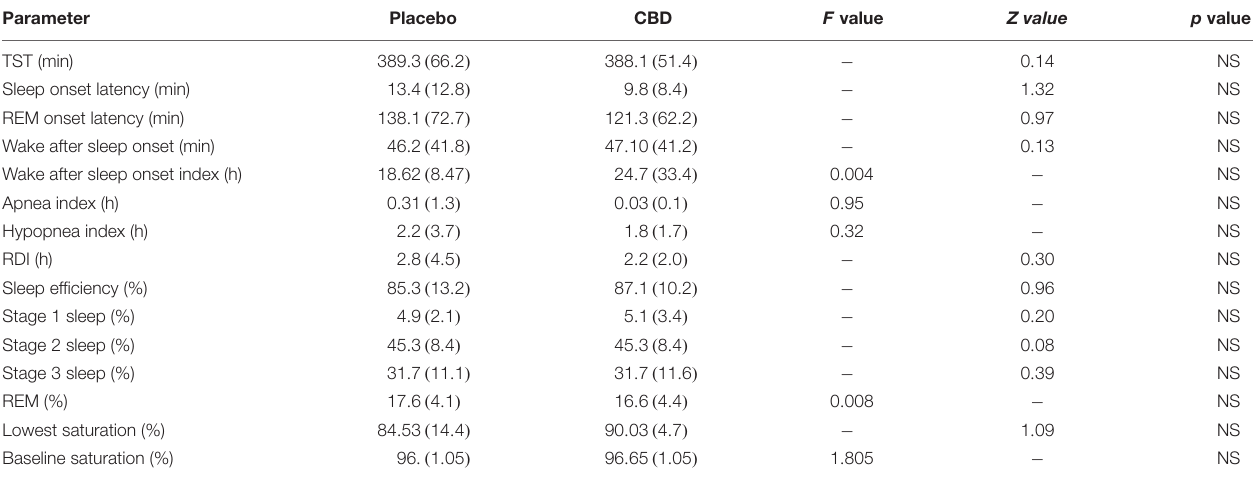
TABLE 3 | Polysomnographic parameters measured after the administration of CBD and placebo. Parameter Placebo